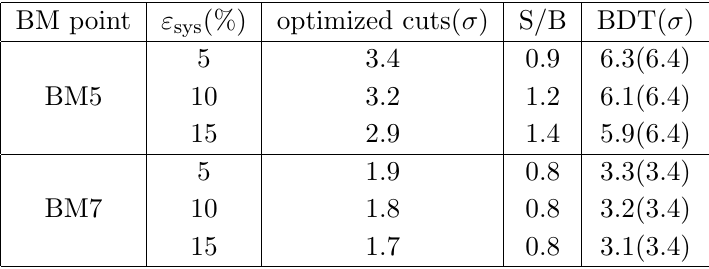
Table 3 . The signal signi(cid:12)cance and the signal-to-background ratio of BM5 and BM7 benchmark points for three systematic uncertainties in the background total rates scenarios | 5, 10 and 15%. The results of the optimized cut-and-count and the corresponding S=B achieved are displayed in the third and fourth columns, and the BDT analysis in the last column. Also, in the last column, we show in parenthesis the results for the joint BDT+cuts optimization.